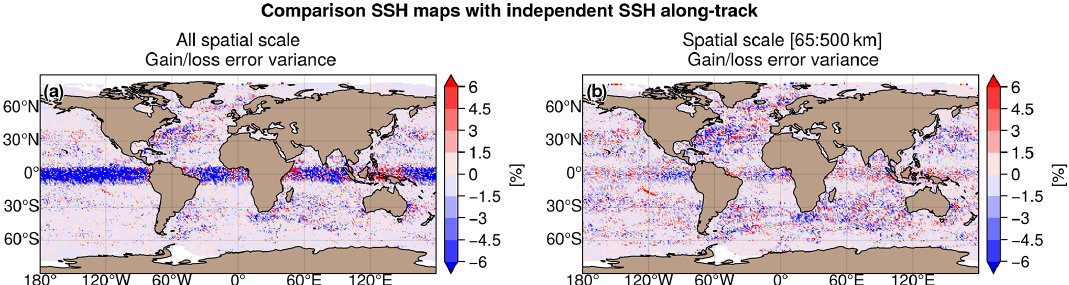
Figure 10. Gain/loss of the mapping error variance of SLA in the MIOST allsat-1 80% drifters + equatorial waves + L3 Arctic experiment relative to the MIOST allsat-1 mapping error variance for (a) all spatial scales and (b) the scale between 65 and 500km. Blue colour means a reduction of error variance in MIOST when drifters are included in the mapping and with equatorial wave parametrization. Table 6. Regionally averaged mapping error variance and gain/reduction of error variance on the SSH variable between MIOST allsat-1 80% drifters + equatorial waves + L3 Arctic and MIOST